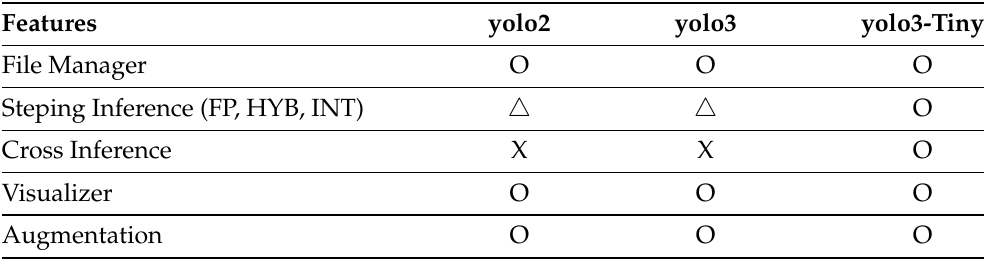
Table 1. Summary of features in the framework with several versions of Darknet object detection deep neural network